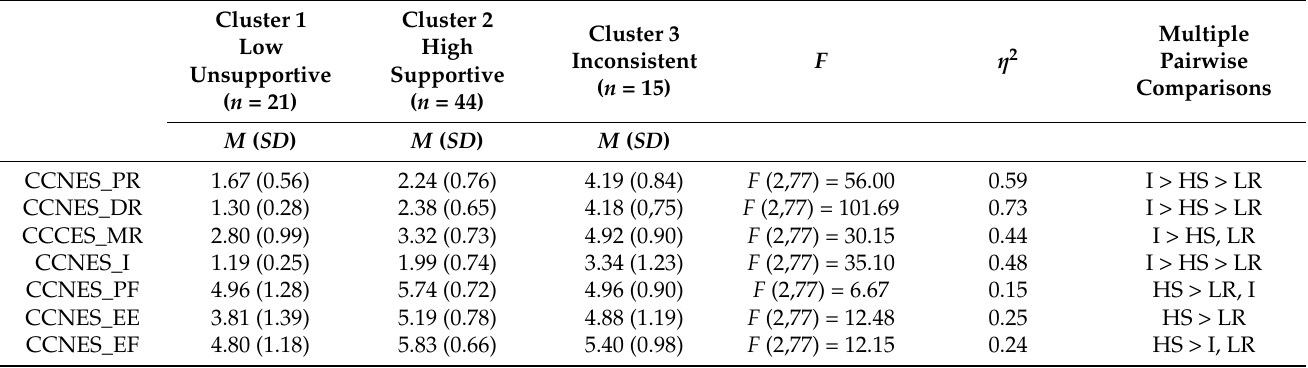
Table 2. Comparisons between parents clusters: means ( M ), standard deviations ( SD ), ANOVAs results, and multiple pairwise